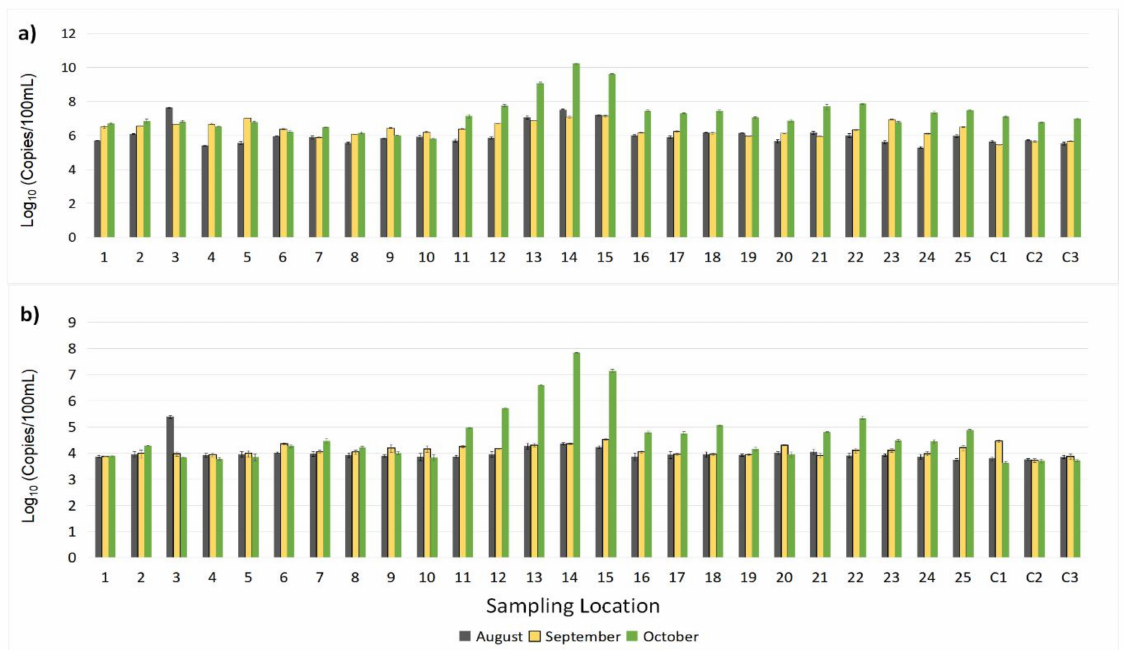
Figure 6. Variations of host-specific fecal MST markers in different locations. ( a ) BacUni. ( b ) HF183. Sampling locations 1–5, LPD lake; 6–10, XDG river; 11–15, WFG river; 16–20, DDT river; 21–25, ZXT river; C1-C3, Control